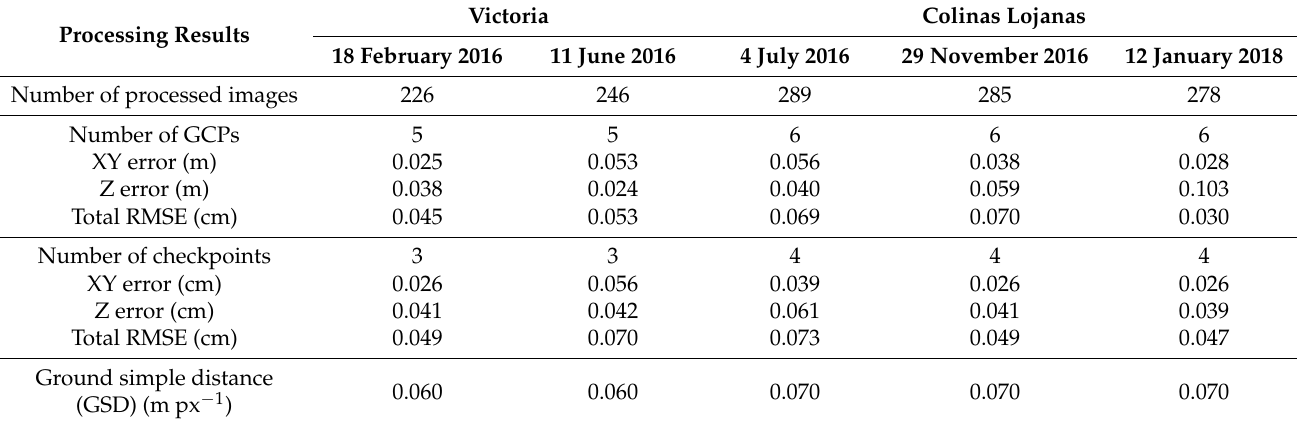
Table 3. Accuracies assessed after processing the images acquired with RPAS by SfM in the two measurement periods. Processing